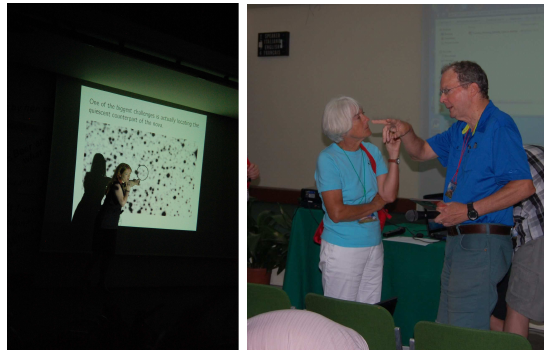
Figure 11: These two pictures surely belongs to the workshop highlights.